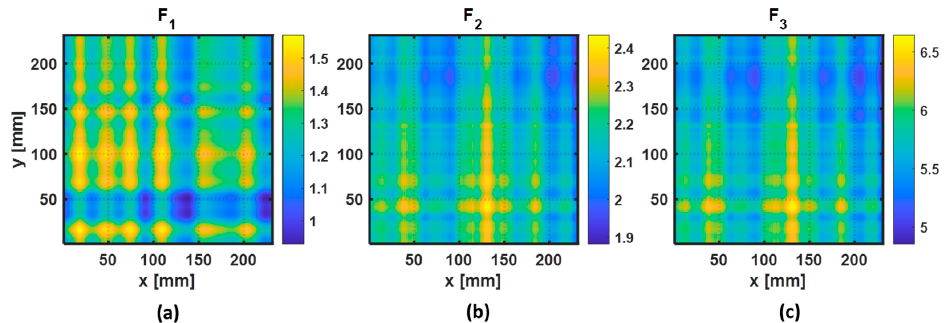
Figure 9. Reconstructed images obtained through the inverse radon transform, using the following features as projection: ( a ) feature F 1 , ( b ) feature F 2 , and ( c ) feature F 3 .